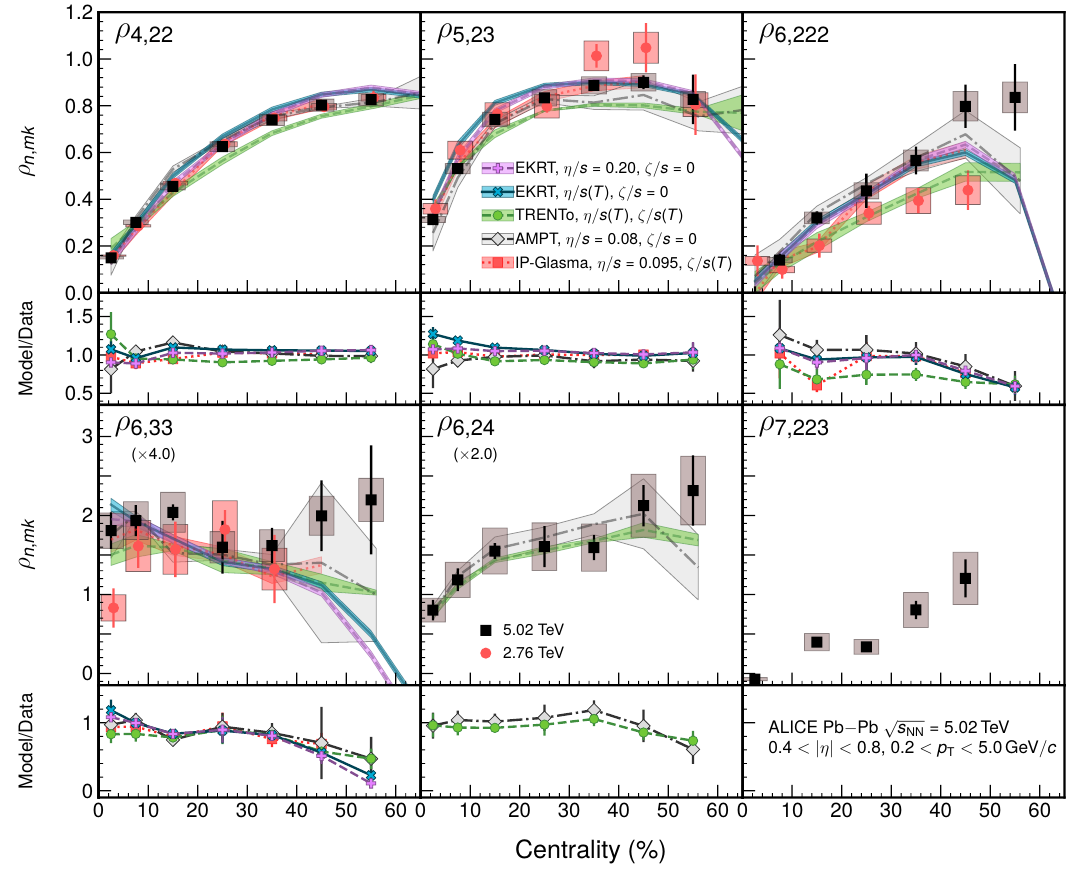
Figure 5 . Symmetry-plane correlations as a function of centrality in Pb-Pb collisions at p s NN = 5 : 02 TeV (black markers) compared with those in Pb-Pb collisions at p s NN = 2 : 76 TeV [53], along with (cid:12)ve di(cid:11)erent hydrodynamic calculations shown as color bands. On the bottom part of each panel, the ratios between model calculations and the data are shown. For some panels, the data points are scaled by an indicated factor for better